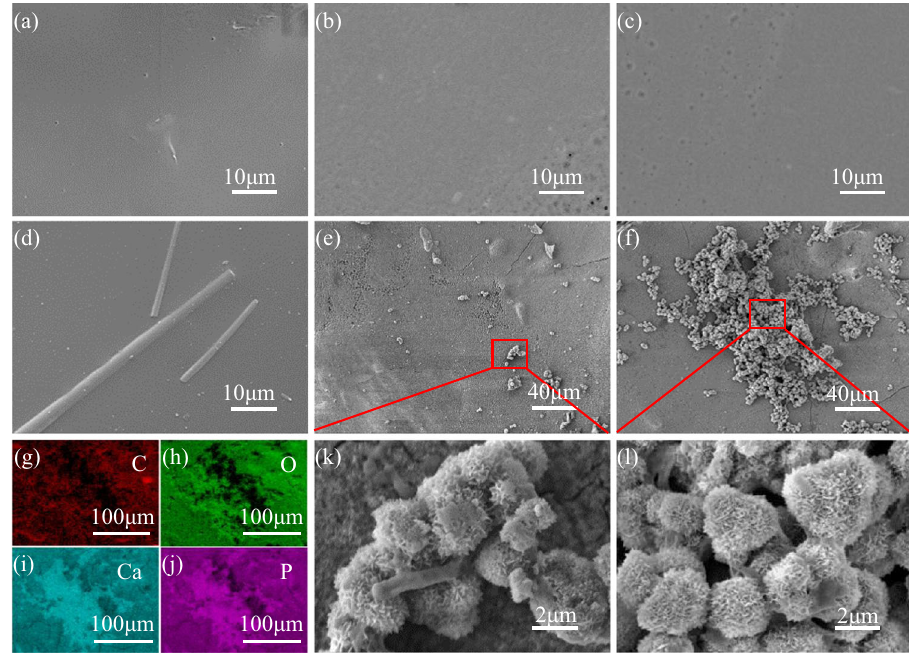
Fig. 6 Mineralization morphologies of the scaffolds. Surface morphologies for ( a ) the initial PLLA scaffold and the scaffold after ( b ) 2-week immersion and ( c ) 4-week immersion, surface morphologies for ( d ) the PLLA/15BCF scaffolds and the formation of calcium phosphate layer after ( e, k ) 2-week immersion and ( f, l ) 4-week immersion, and the EDS images of formed calcium phosphate layer for ( g ) C, ( h ) O, ( i ) Ca and ( j ) P elements.